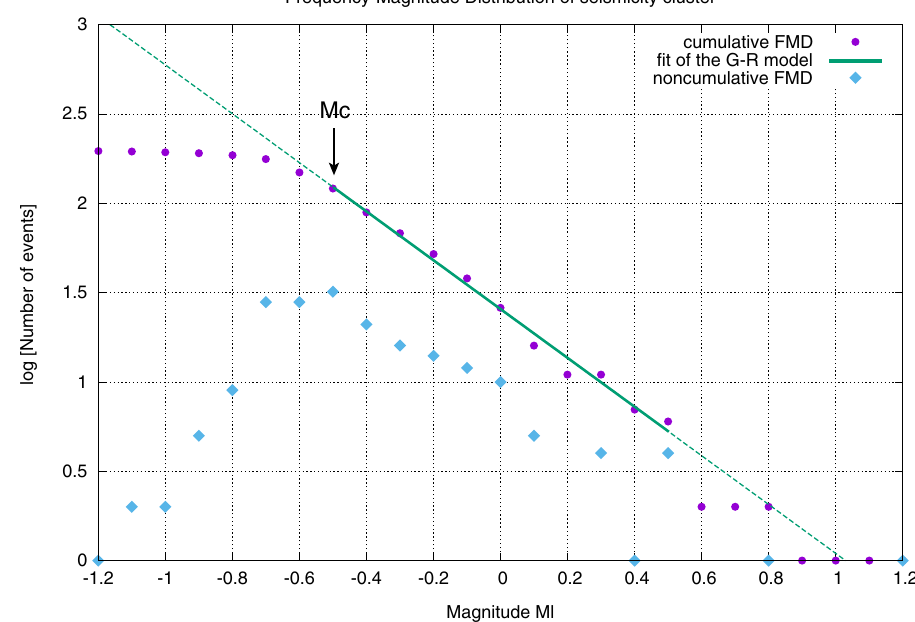
Figure 3. The frequency–magnitude distribution (FMD) of the analyzed induced seismicity cluster. The green line indicates the fit of the Gutenberg-Richter model over the local magnitude range Mc ≤ Ml ≤ 0.5, where Mc = − 0.5 is the completeness magnitude. The dashed green line is the extrapolation of the Gutenberg-Richter model for the higher and the lower local magnitude values. Circles and diamonds represent the cumulative and the noncumulative FMD,